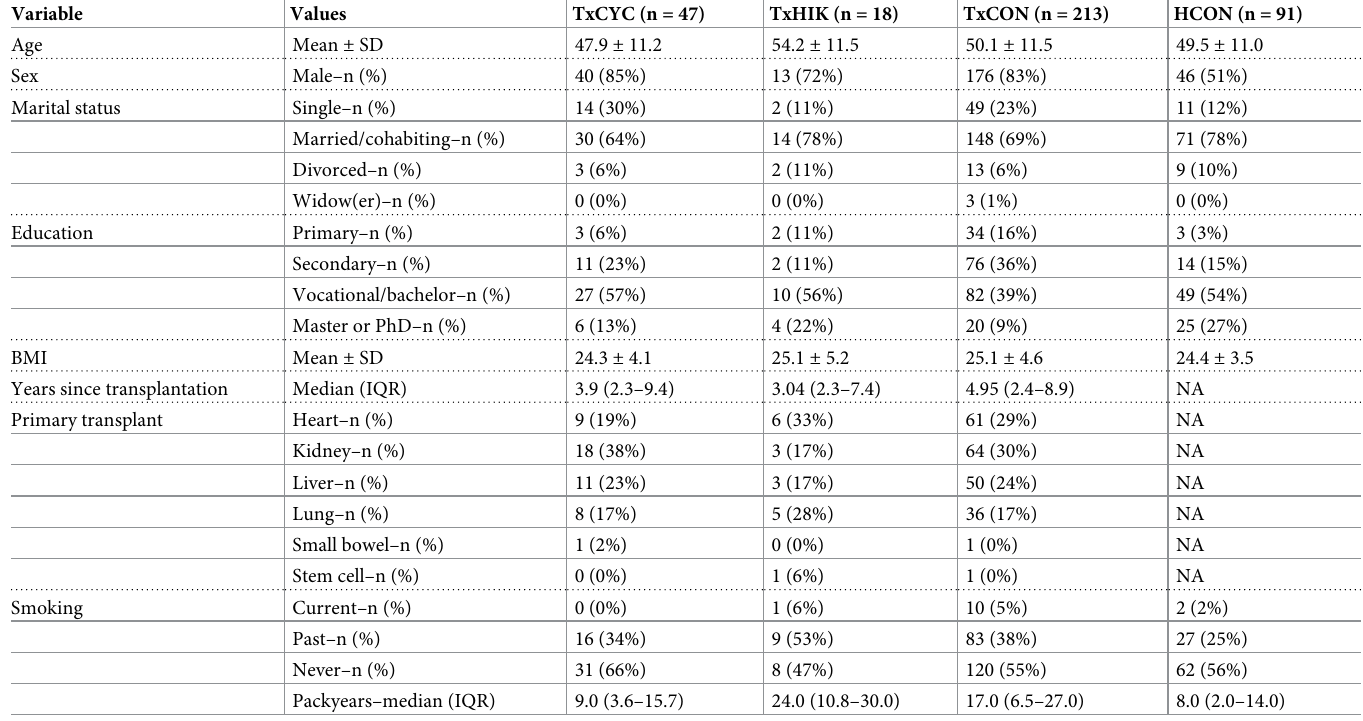
Table 1. Demographic characteristics of the study population at baseline.